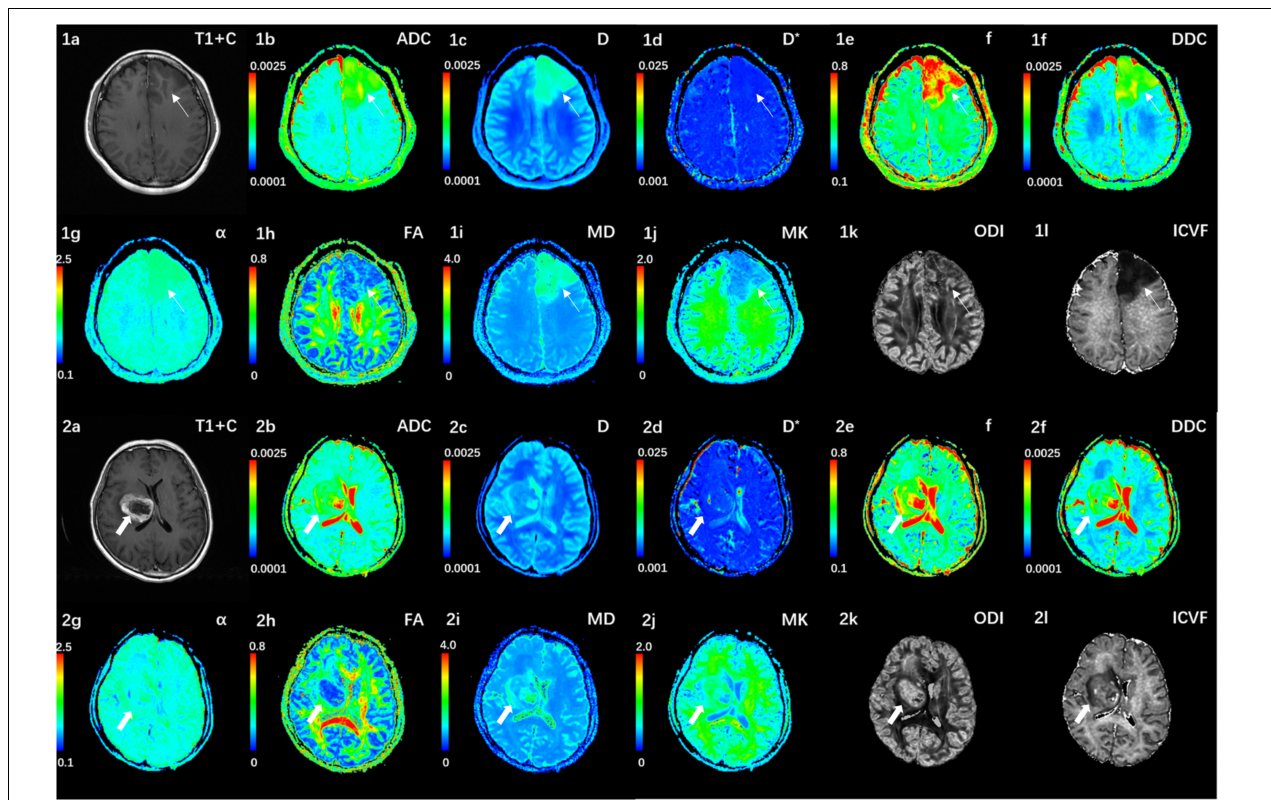
FIGURE 1 | (1a–l) Correspond to a 38-year-old female with a IDH1-mutant grade III glioma in the left frontal lobe (white thin arrow). The ADC, MD, D, f, and DDC as well as α maps show increased values in the solid part of the tumor, while D*, MK, ODI, and ICVF maps show decreased values. (2a–l) Corresponds to a 59-year-old female with a IDH1 wild-type grade III glioma in the right basal ganglia (white thick arrow). The ADC, MD, D, f, and DDC as well as α maps show decreased values in the solid part of the tumor, while D*, MK, ODI, and ICVF maps show increased values. ADC, D, D*, and DDC as well as MD are in units of 10 − 3 mm 2